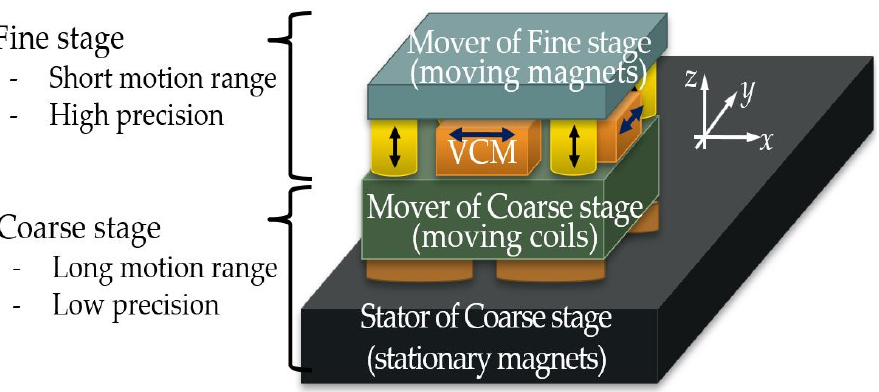
Figure 1. Schematic diagram showing the structure of the dual servo maglev stage.